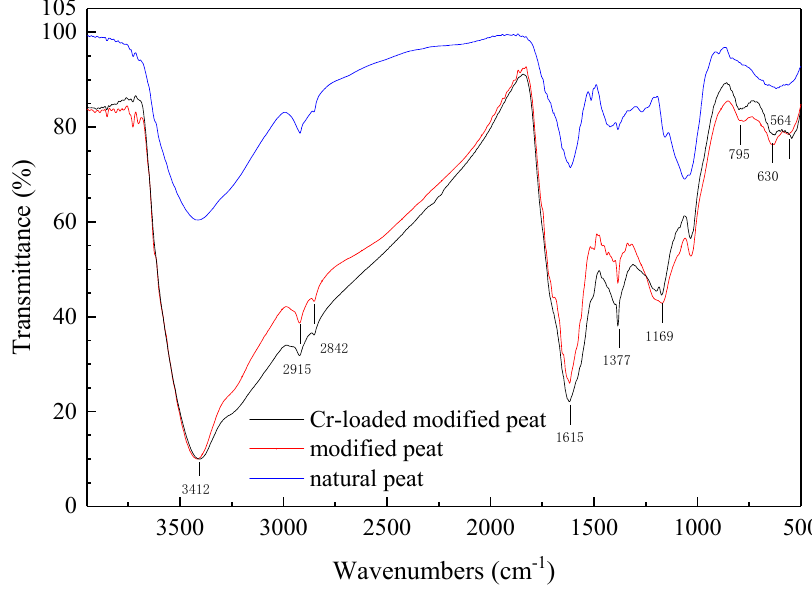
Figure 3. FT-IR spectra of the natural, modified, and Cr-loaded modified peat .